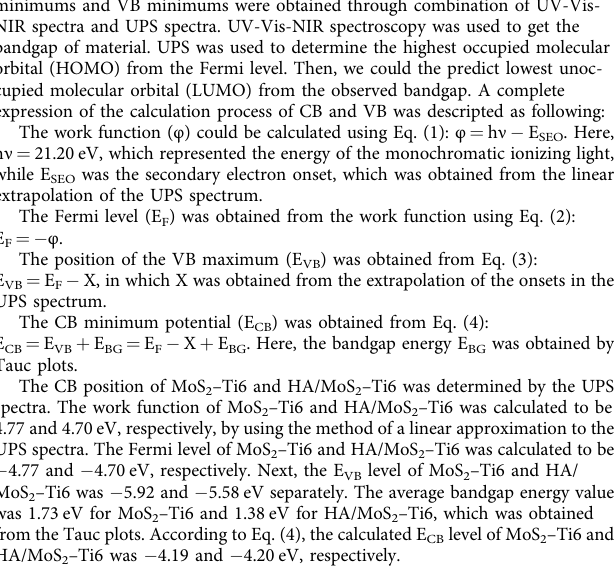
Fig. 6 Bone integration of HA/MoS 2 -Ti6 in vivo. a H&E staining of bone tissues around the implants under different conditions ( n = 8 independent samples), scale bar = 100 μ m. b Giemsa staining of bone tissues around the implants ( n = 8 independent samples), scale bar = 100 μ m. c In vivo antibacterial evaluation, (Left) the remaining bacteria colonies on Ti6 and HA/MoS 2 -Ti6 rods pulled out from the tissues after implantation for 14 days, (Right) the optic pictures of bacteria extracted from the implants of Ti6 and HA/MoS 2 -Ti6 after culturing for 24h. d Antibacterial ability of HA/MoS 2 -Ti6 compared with Ti6 in vivo. ( n = 8 independent samples). e The 2D and 3D pictures of HA/MoS 2 -Ti6 and Ti6 groups measured by Micro-CT. f Bone volume (BV)/tissue volume (TV) values of HA/ MoS 2 -Ti6 and Ti6 groups. ( n = 8 independent samples). g Methylene blue-acid magenta staining of the newly formed bone tissues on the bone-implant interface, scale bar = 100 μ m. h Bone area ratios of samples calculated from the methylene blue-acid magenta staining. ( n = 3 independent samples). i Safranin-O/Fast Green staining. The green color is osteogenesis, and the red or orange color is cartilage. The scale bar is 100 μ m. j Histomorphometric measurements of osteogenesis. The area was taken from 20 μ m around the implant. The control was Ti6 + S. aureus group. ( n = 3 independent samples). k Biological assessment of heart, liver, spleen, lung, and kidney ( n = 8). The scale bar is 100 μ m. d , f , h , j Data represented as mean±standard deviations from a representative experiment. Error bar represents the standard deviation. p -values were generated by two-way ANOVA with Dunnett ’ s multiple comparison test. Source data are provided as a Source Data fi